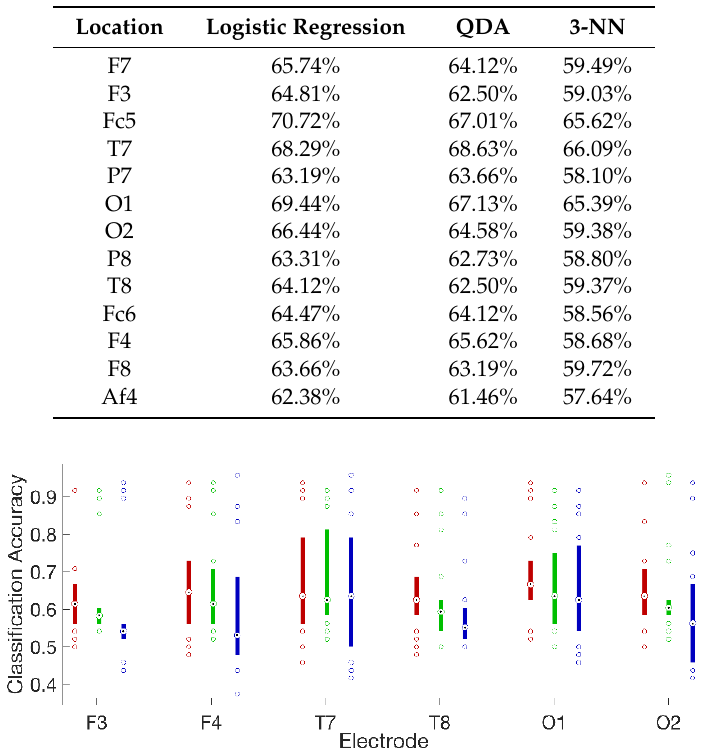
Figure 5. Topographical plots of classification performance averaged across all 18 subjects for the: ( A ) logistic regression; ( B ) quadratic discriminant analysis; and ( C ) three-nearest neighbor classifiers. Values represented by the color maps are the proportion of correctly labeled examples. Values at non-electrode locations were obtained via biharmonic spline interpolation [33]. The electrode labeling convention follows the Modified Combinatorial 10 – 20 Standard [24]. Table 2. Electrode-specific classification performance averaged across all 18 subjects for the logistic regression, quadratic discriminant analysis, and three-nearest neighbor classifiers.